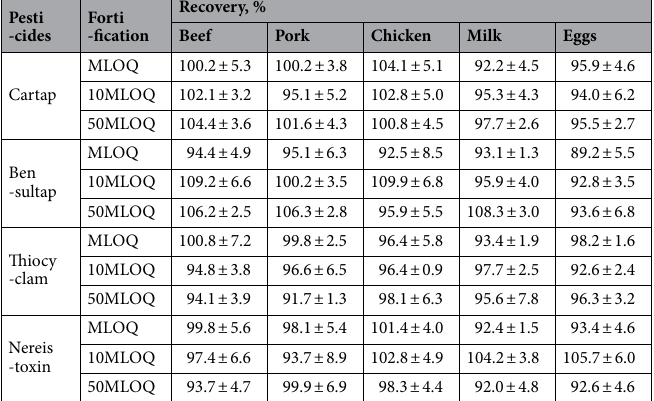
Table 3. Recovery efficiencies (n = 3) determined for the nereistoxin insecticides and nereistoxin in foods of animal origins.